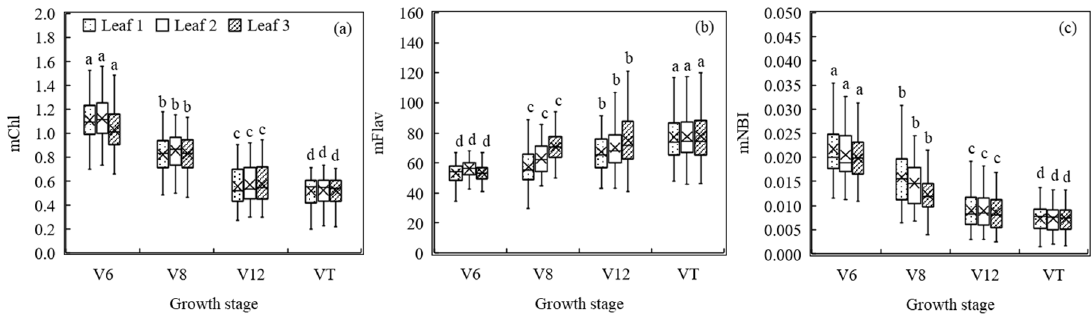
Figure 5. Modified Dualex 4 parameters (modified Chl (mChl) ( a ), modified Falv (mFlav) ( b ), and modified (mNBI)) ( c ) as a ff ected by growth stage. Di ff erent letters above the boxes indicate that the modified Dualex 4 parameter values di ff ered significantly according to the least significant di ff erence test at p ≤ 0.05.